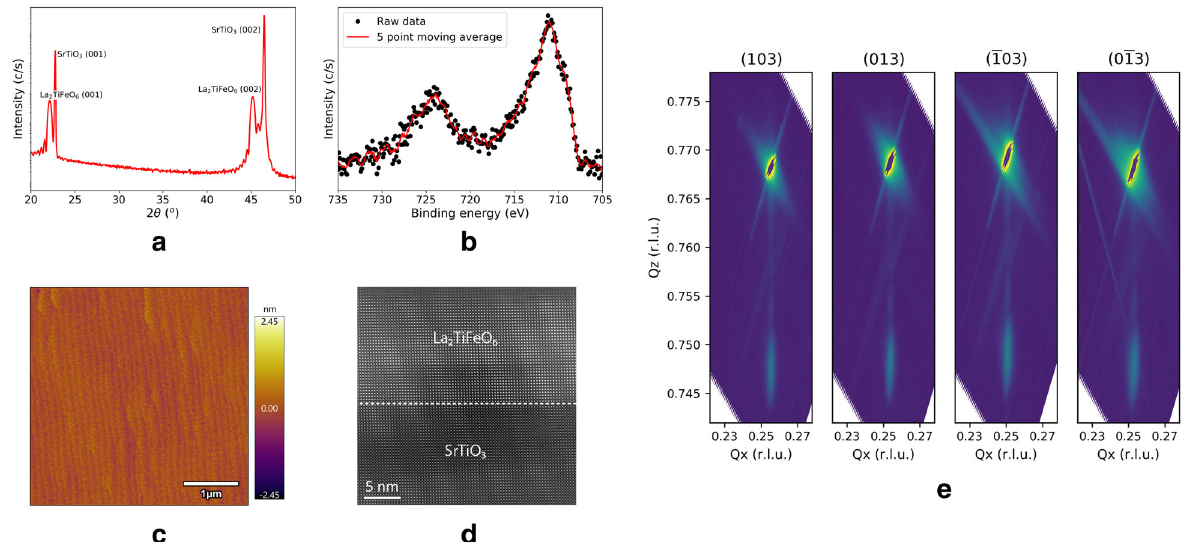
Fig. 1 Characterization of a La 2 TiFeO 6 fi lm on a SrTiO 3 (001) substrate. XRD ( a ) shows peaks corresponding to single-phase perovskite La 2 TiFeO 6 , but peaks indicating B-site ordering of Ti and Fe are absent. XPS ( b ) shows the presence of Fe 2 + in (001) oriented fi lms and is visible as a shoulder around 709 eV. XPS additionally shows Ti is completely 4 + (data not included). c AFM measurements show smooth fi lms with terrace height differences of 0.5 unit cells. Also, TEM ( d ) reveals a high structural quality of the grown fi lms and the absence of B-site order. e XRD reciprocal space mapping around the (103) re fl ection reveals that the strained fi lm exhibits tetragonal symmetry with cell parameters a = 3.905 Å and c = 4.01 Å